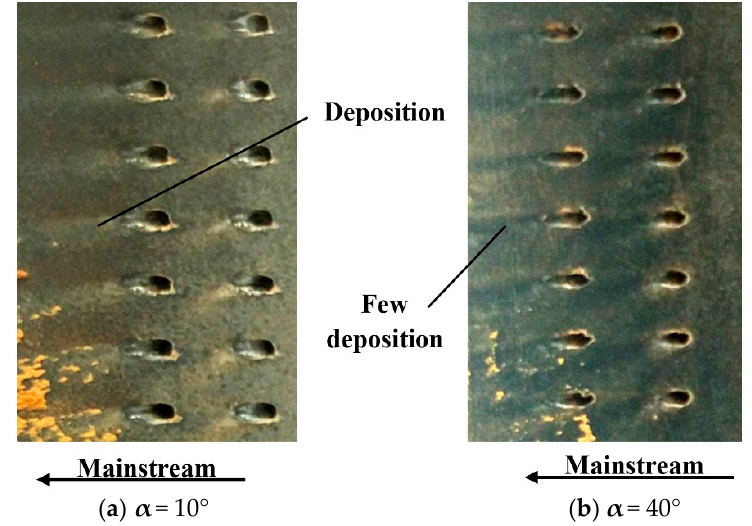
Figure 21. Close views of deposition in the cases of 10° and 40°.